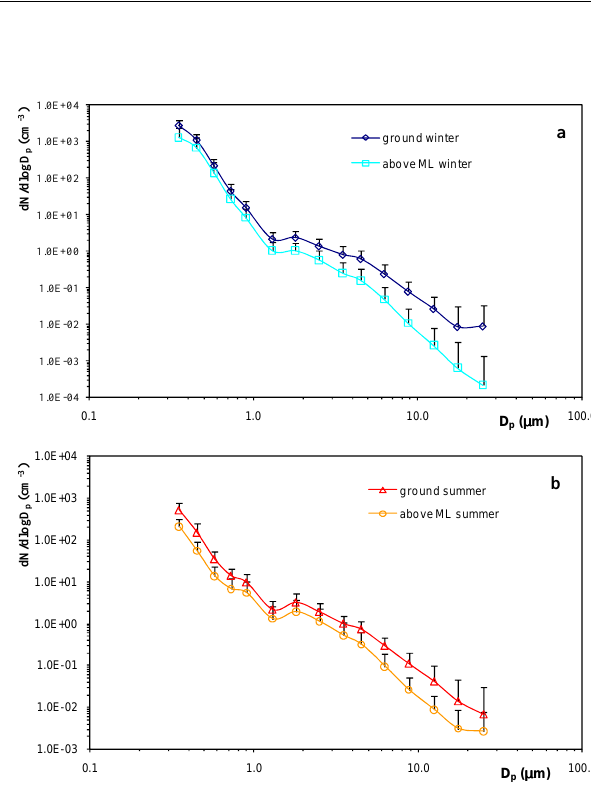
Fig. 5. Number-size distribution of aerosol at ground-level and above the ML both in winter (a) (DJF months; N profiles=142) and summer (b) (JJA months; N profiles=72).